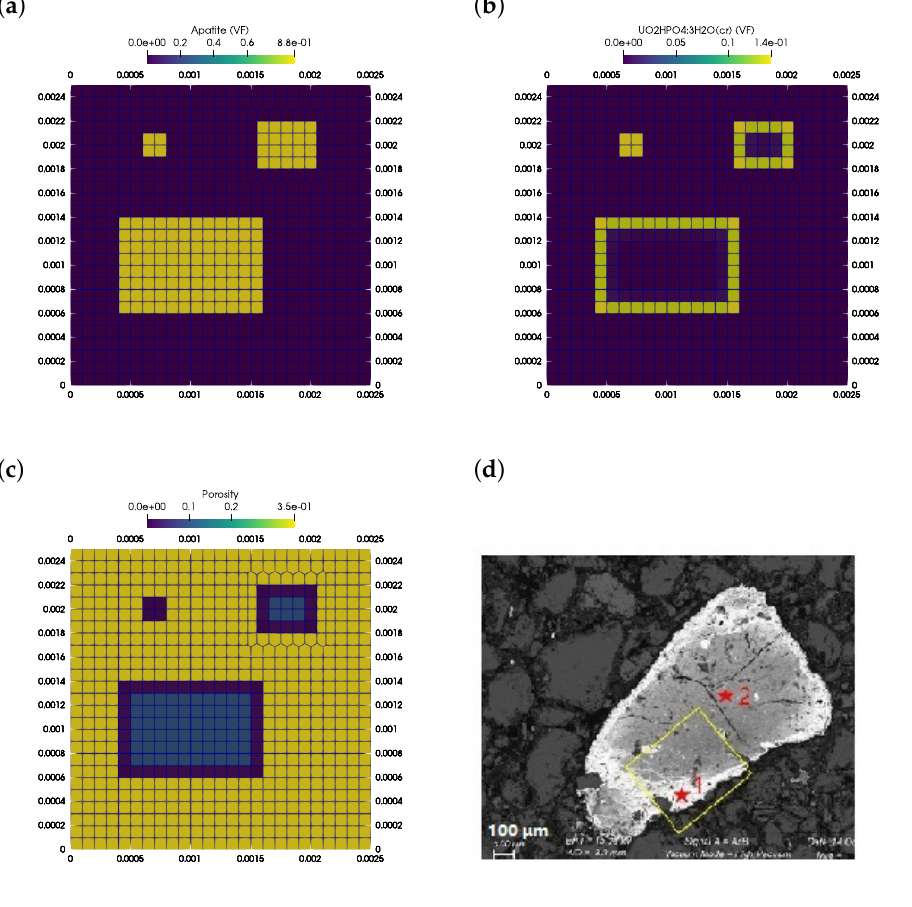
Figure 6. Reactive transport simulation of the concomitant dissolution of apatite and precipitation of uranyl phosphate. ( a ) Initial grains of apatite millimetric to submillimetric sizes. ( b ) Localization of UP precipitation. ( c ) Resulting porosity distribution. ( d ) SEM image of a large apatite grain rimmed by UP